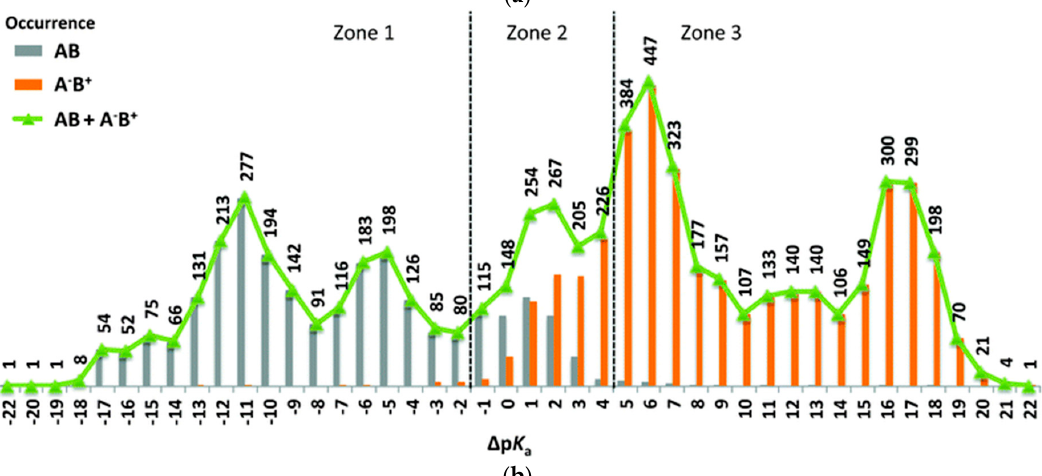
Scheme 1. ( a ) The pKa rules of thumb to predict the H-bonding motifs in multi-component